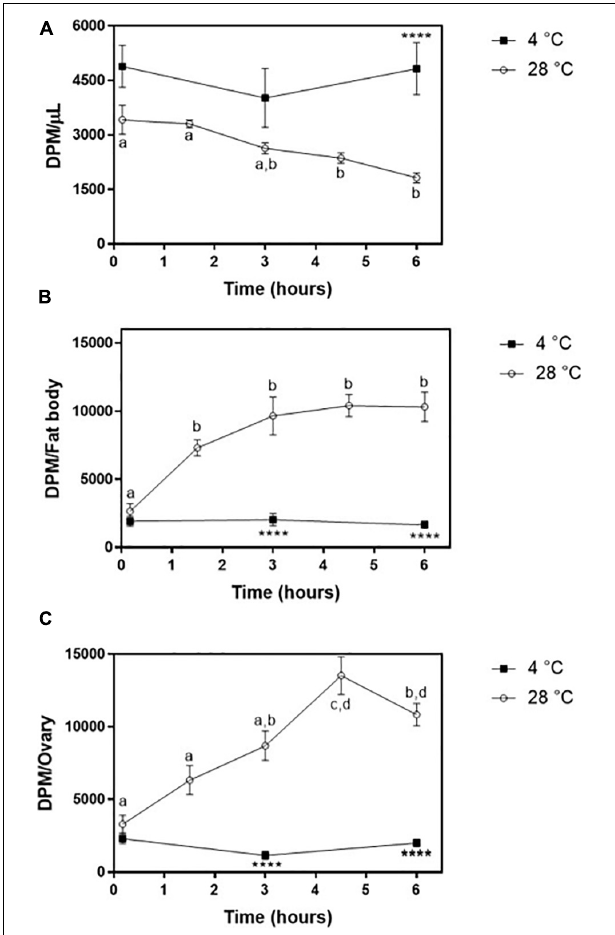
FIGURE 7 | Lipophorin transport of 3 H-cholesterol to the fat body and ovaries. Rhodnius prolixus adult females were injected with 3 H-cholesterol-Lp on the third day after the blood meal and maintained to 28 ◦ C ( (cid:13) ) or 4 ◦ C ( (cid:110) ) . (A) At the indicated times, hemolymph was collected, and radioactivity was quantified and expressed as DPM/ µ l ± SEM for six to 12 determinations. The same insects were dissected, and fat body (B) and ovaries (C) were isolated. After homogenization, radioactivity in the organs was determined and expressed as DPM/organ ± SEM for 7–12 determinations. Different letters indicate statistical difference between the values of insects at 28 ◦ C by one-way ANOVA followed by Tukey’s posttest. (****): significant difference between 4 and 28 ◦ C by two-way ANOVA followed by Sidak’s multiple comparisons posttest, p < 0.0001. DPM, disintegrations per